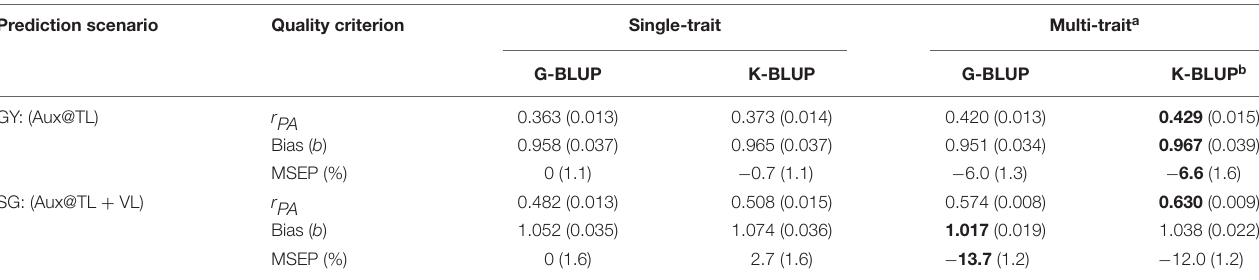
TABLE 2 | Predictive abilities ( r PA ), regression coefficients (Bias), and relative MSEP from single-trait G-BLUP and K-BLUP, and from the best-predictive multi-trait G-BLUP and K-BLUP models for GY prediction using auxiliary traits data on training lines (Aux@TL) and for SG prediction using auxiliary traits data on both training and validation lines (Aux@TL +